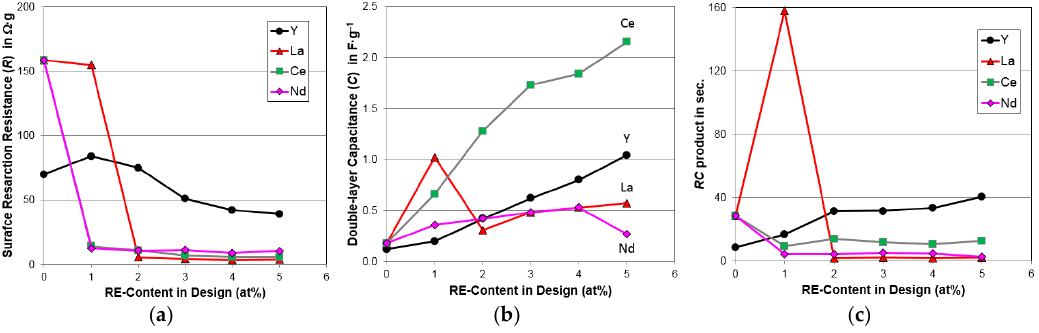
Figure 15. Correlations between surface reaction current and ( a ) TiNi phase abundance; and ( b ) RENi phase abundance. Batteries 2016 , 2 , 25